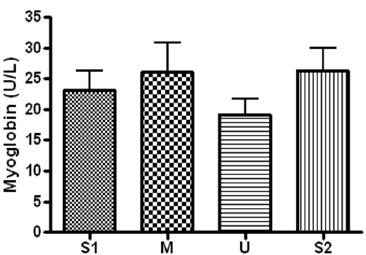
Figure 5. Serum myoglobin concentration in different locations. Values are mean ± S.D. S1: Before start in Seoul, M: Moscow U: Ulaanbaatar S2: Return to Seoul.